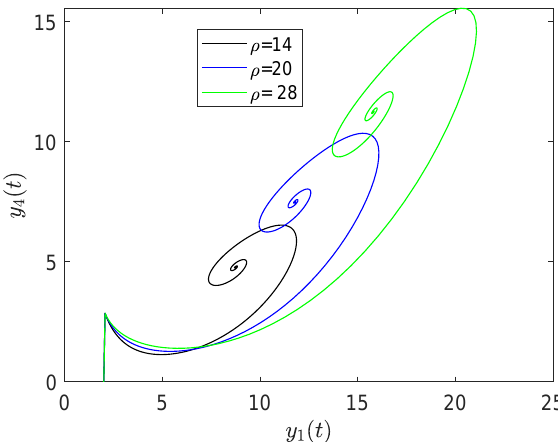
Figure 45. Phase portraits of y 1 and y 4 when varying ρ